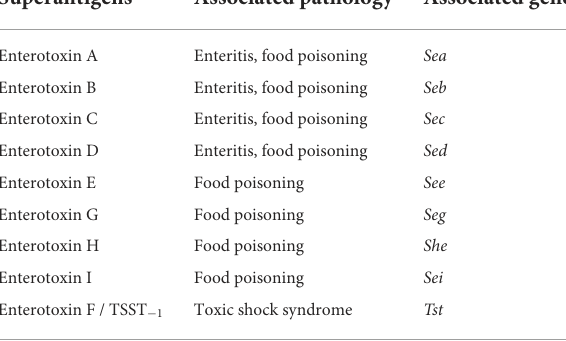
TABLE 3 Superantigens produced by S. aureus, along with associated pathology and